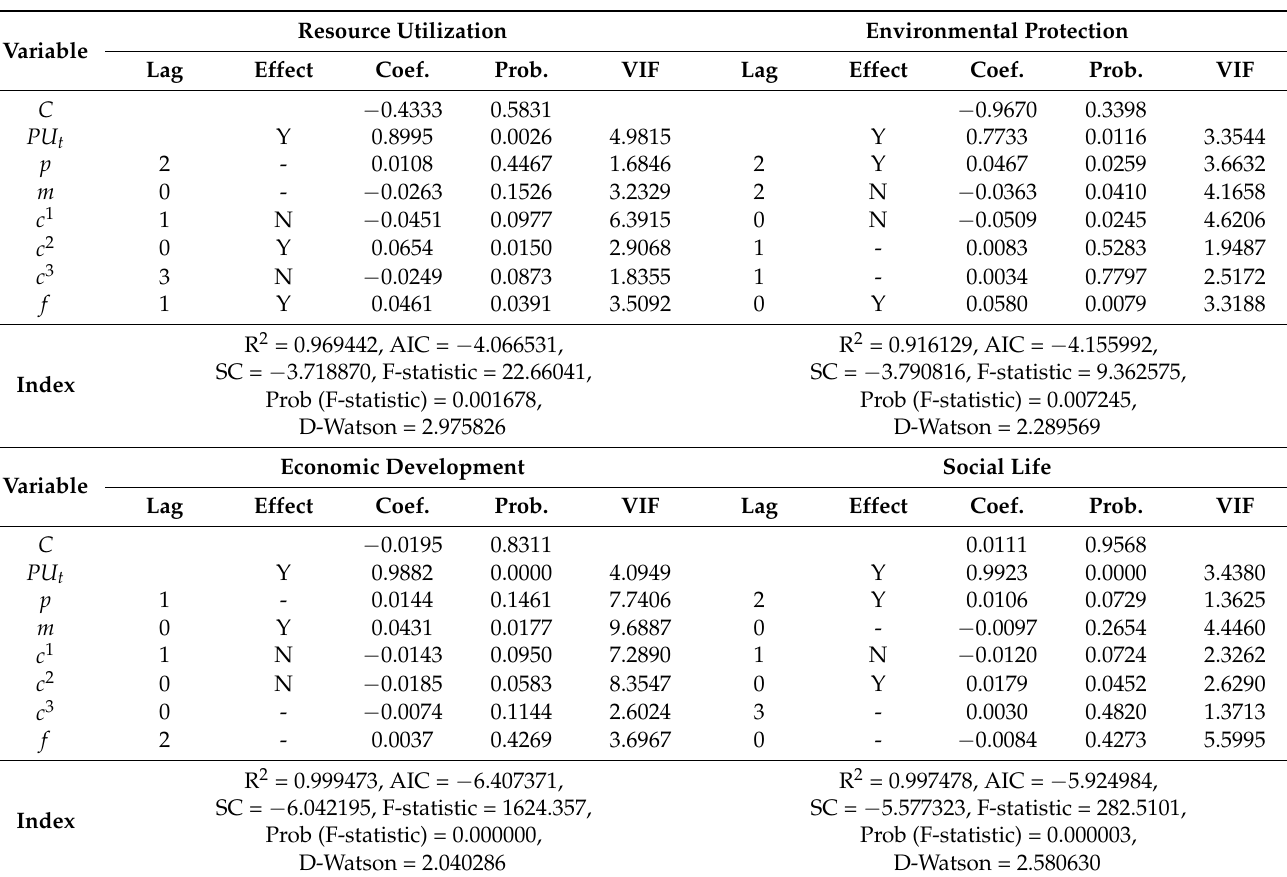
Table 4. Analysis of the effectiveness of ecological civilization policies from 2004 to